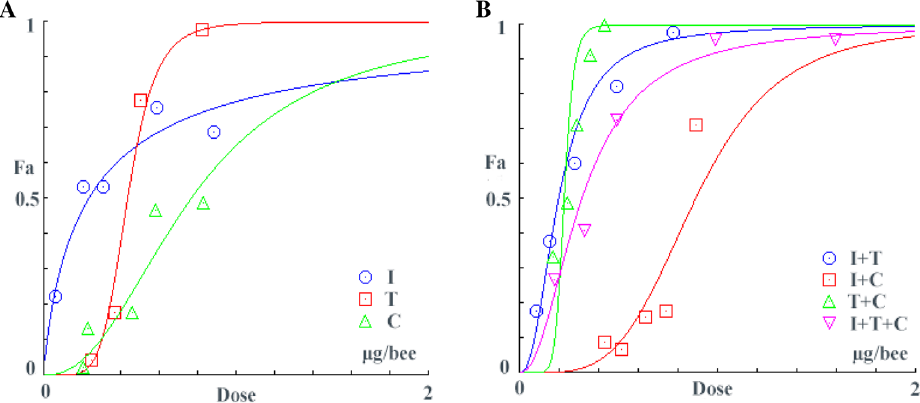
Figure 4. Dose–effect diagram of pesticides ( A ) and pesticide combinations ( B ). Note C = chlorpyrifos; I = imidacloprid; T =